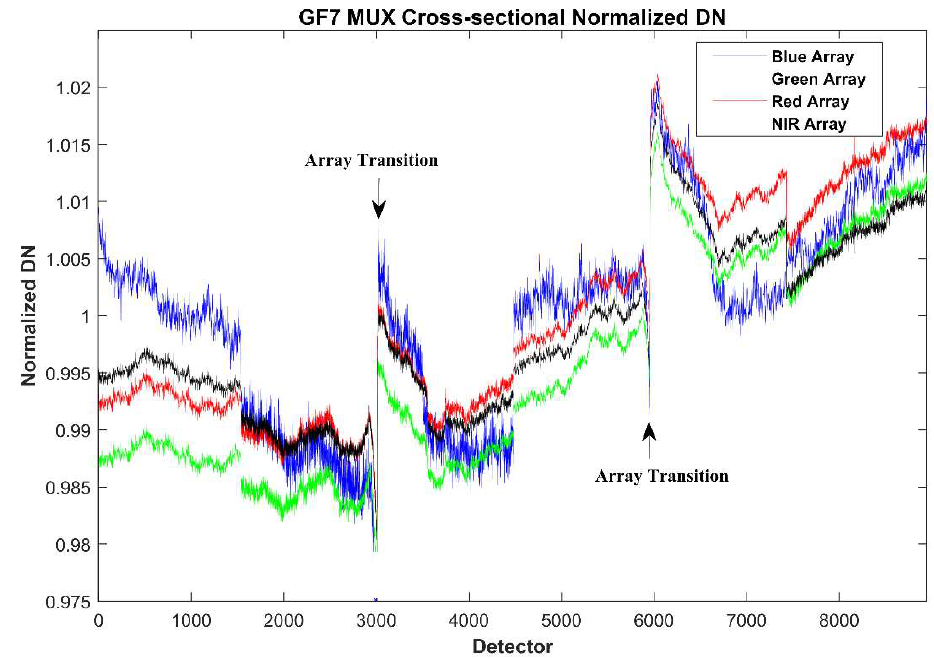
Figure 5. The normalized DN in the along-track direction of the uniform Libya 4 PICs.